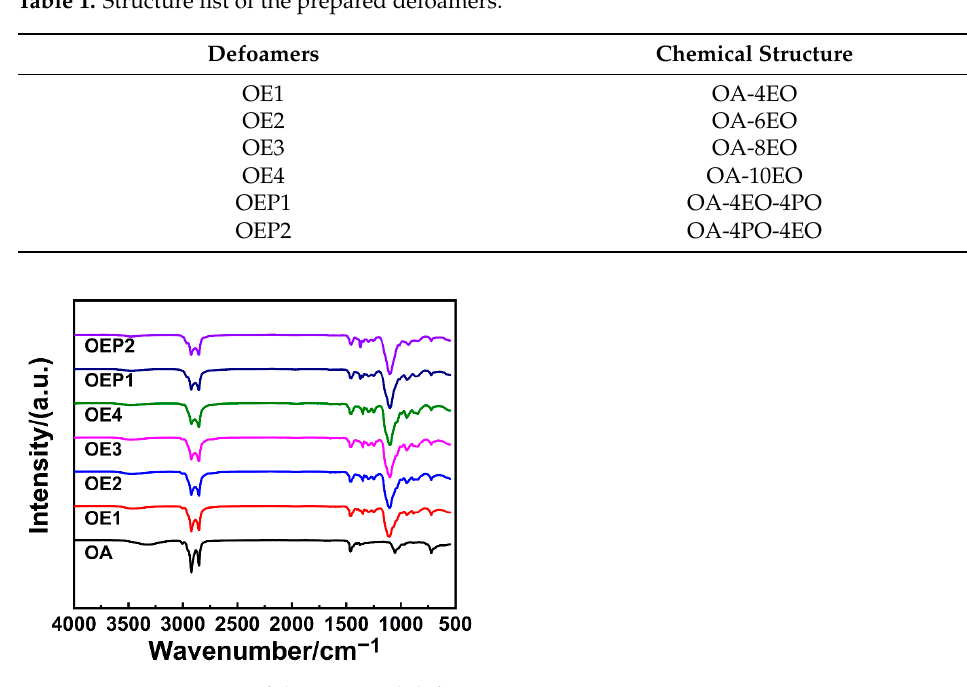
Figure 2. FT-IR spectra of the prepared defoamers.